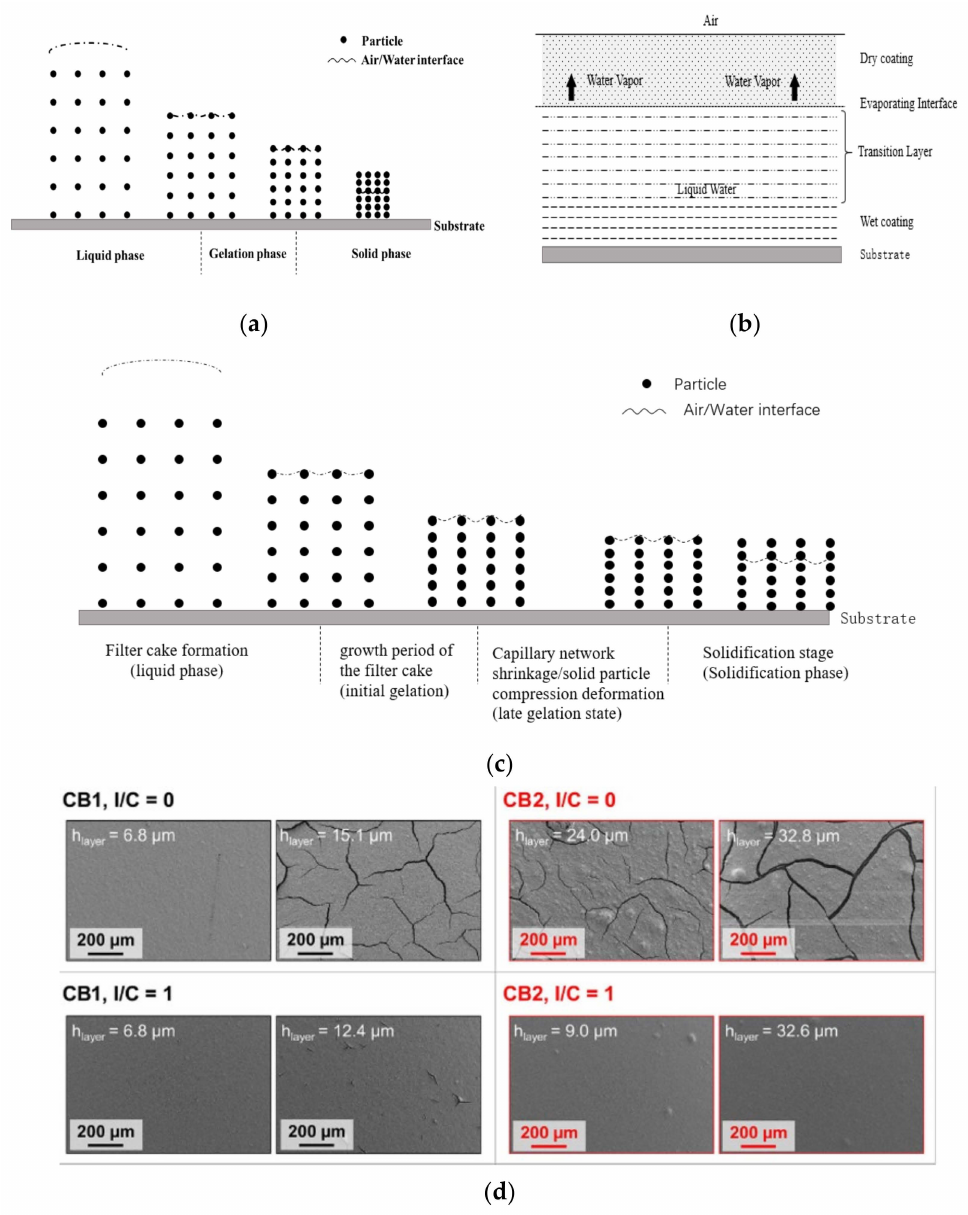
Figure 10. ( a ) Classic consolidation mechanism of coating layer proposed by Lepoutre [193]. ( b ) Croll’s film formation model [194]. ( c ) Schematic of the consolidation mechanism of filter cake layer on coating surface [191]; ( a – c ) adapted from [195]. ( d ) SEM micrographs of CL cracks after drying [27]. Copyright 2019